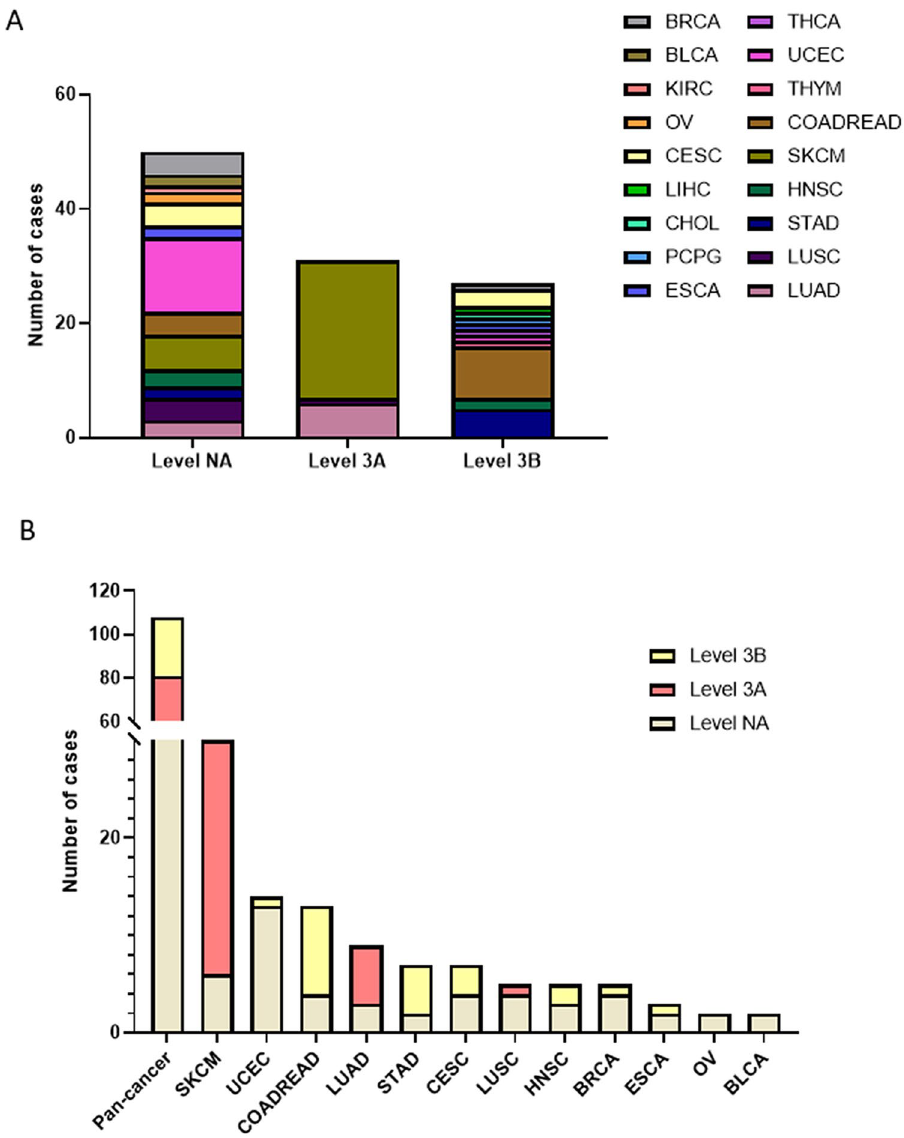
top 12 types of